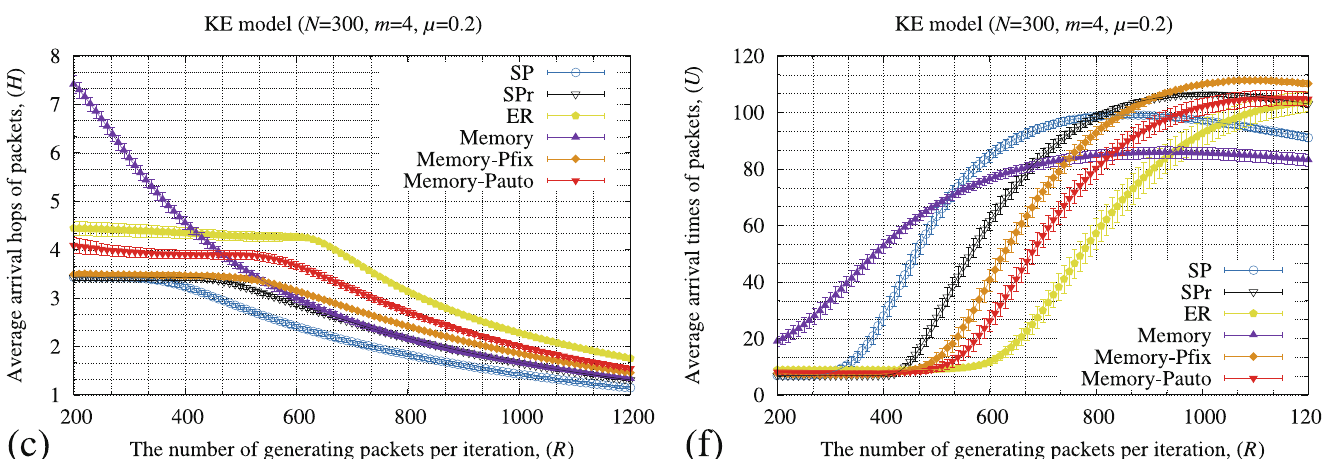
Fig 10. Relationships between the number of generating packets at each iteration ( R ) and the average hop of arriving packets ( H ) of the SP, SPr, ER, memory, memory-pfix, and memory-pauto methods for the (a) BA, (b) WS, and (c) KE models, and the average arrival times of arriving packets ( U ) for the (d) BA, (e) WS, and (f) KE models. In these figures, the standard deviation of each method is plotted as error bars.